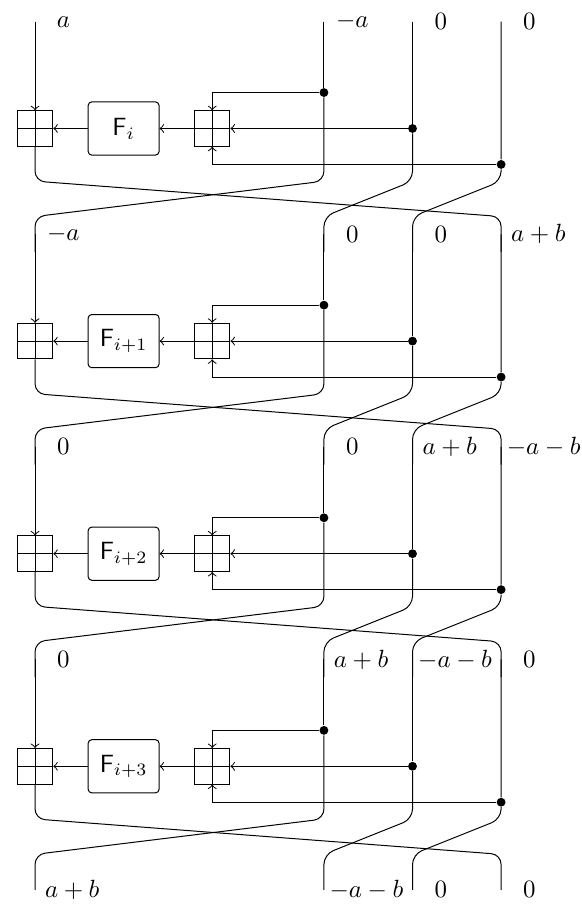
Figure 2: Truncated differential for a contracting generalized Feistel cipher with t = 4 branches. The probability of this trail is 1 /N . In characteristic two, the minus signs may be